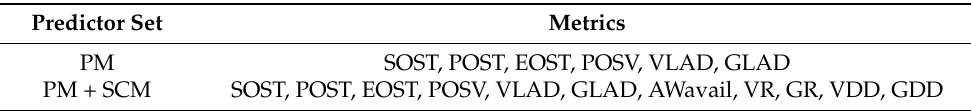
Table 2. Sets of yield predictors tested: phenological (PM) and phenological plus seasonal climate metrics (PM +